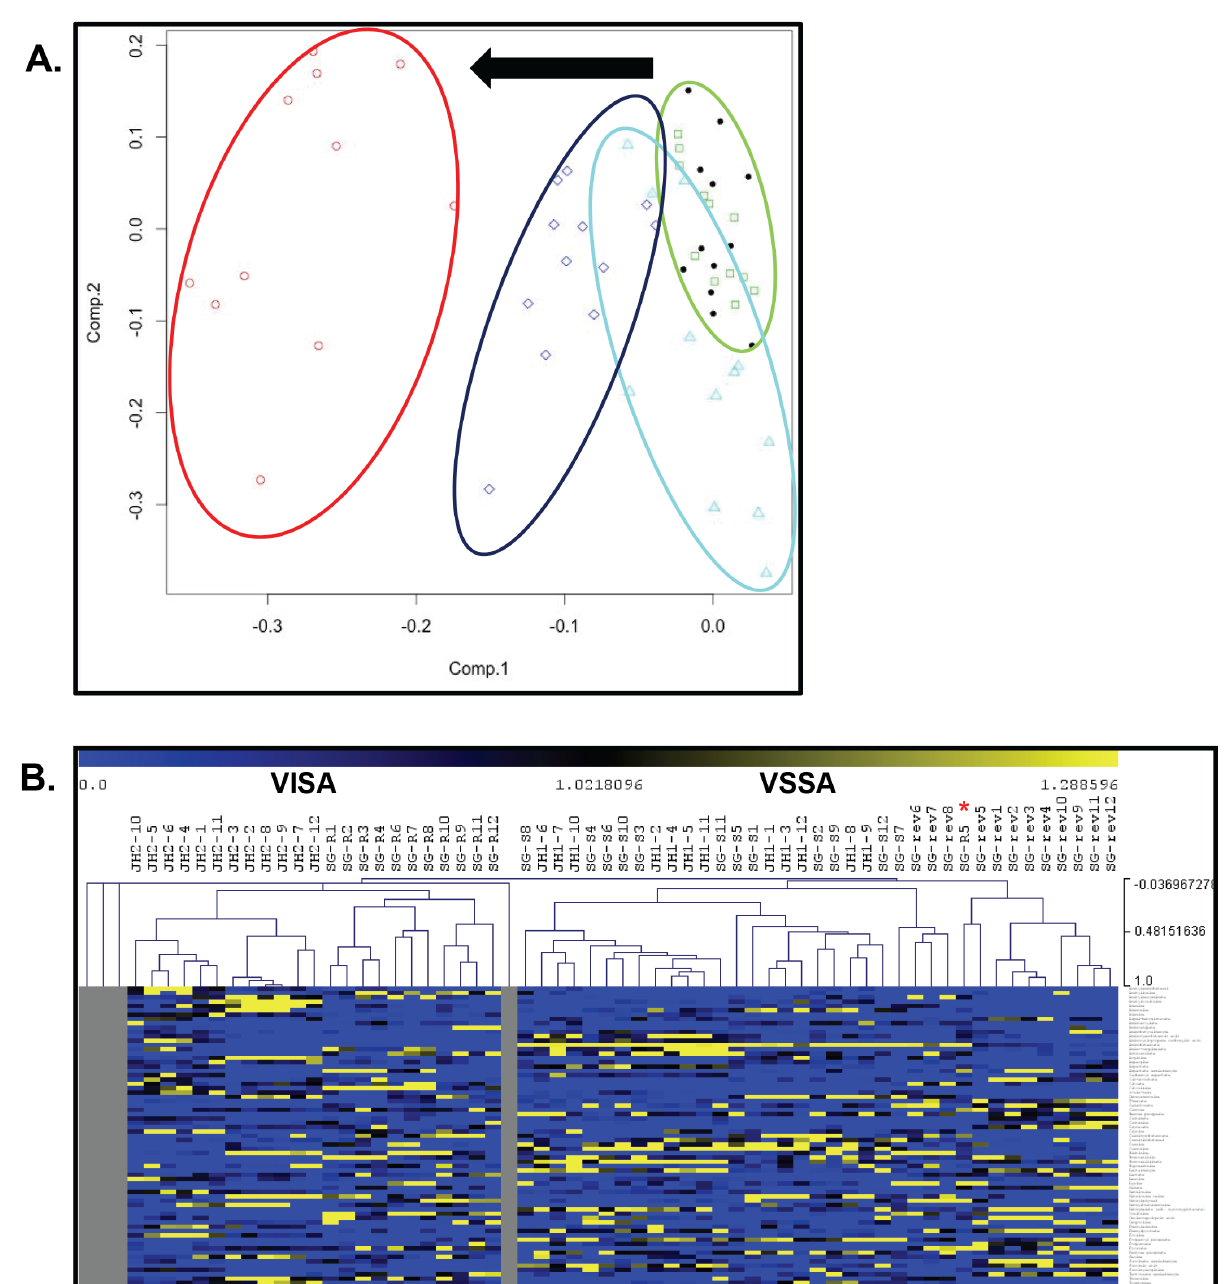
Figure 2. Principal component and hierarchical cluster analyses show separation of isolates by resistance phenotype. Principal component analysis (A) of the metabolic profiles of all isolates from both series again shows a separation of isolates by resistance phenotype. Specifically, the metabolic profiles of parent VSSA isolates SG-S (green squares) and JH1 (black dots) form a single cluster (green ellipse), while those corresponding to VISA isolates SG-R (dark blue diamonds) and JH2 (red circles) form two separate clusters (dark blue ellipse and red ellipse, respectively) along the same vector of change (denoted by the black arrow) to the left of the VSSA cluster. The metabolic profiles corresponding to the revertant SG-rev (light blue diamonds) cluster between the susceptible parent (SG-S) and resistant (SG-R) isolates, consistent with its revertant phenotype (light blue ellipse). (B) Results of hierarchical cluster analysis also show that the metabolic profiles of all five isolates from both series separate by resistance phenotype, forming two distinct branches with the VISA isolates JH2 and SG-R on the left and VSSAs SG-S, JH1 and SG-rev on the right, though one replicate of SG-R (SG-R5) was found to cluster with the parental VSSA isolates (red asterix). doi:10.1371/journal.pone.0097137.g002 TCA cycle, glycolysis/gluconeogenesis/pentose phosphate path- Of the 7 metabolites whose intracellular abundance was way and pyruvate metabolism, of which seven subsequently significantly altered in both series of isolates on hierarchical reversed in the direction of the parental isolate (albeit sometimes mixture modeling, and returned in the directionality of baseline in the revertant, SG-rev (albeit sometimes imperfectly), 6 changed in imperfectly) in the revertant, SG-rev (Figure 4).